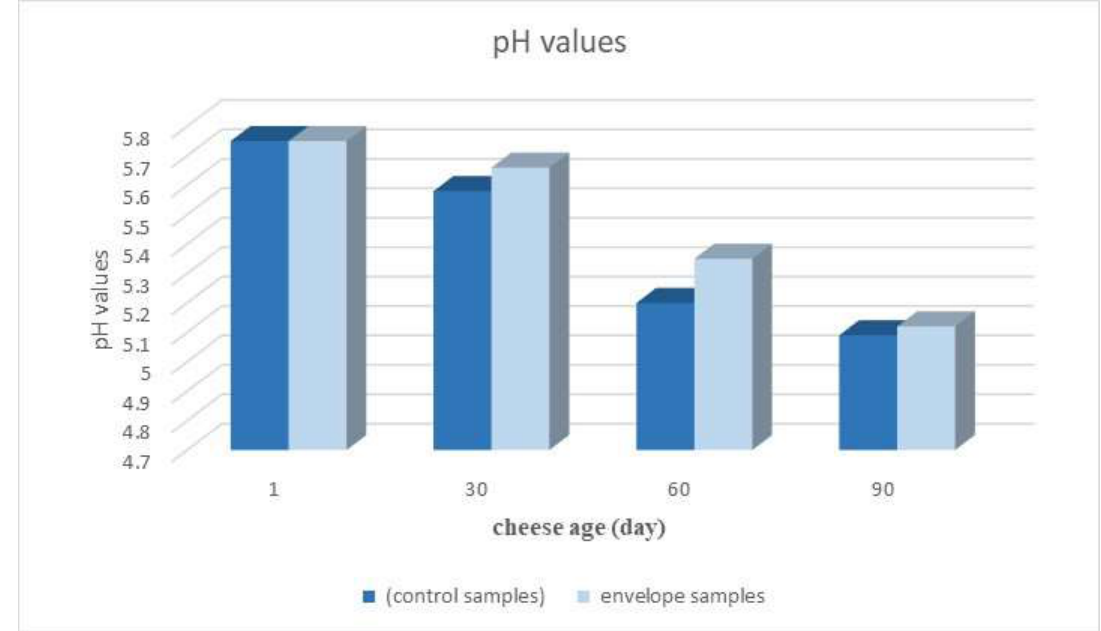
Figure 4 : pH values of treatments for unwrapped mozzarella cheese (control sample) and cheese samples coated (enveloped sample) during storage